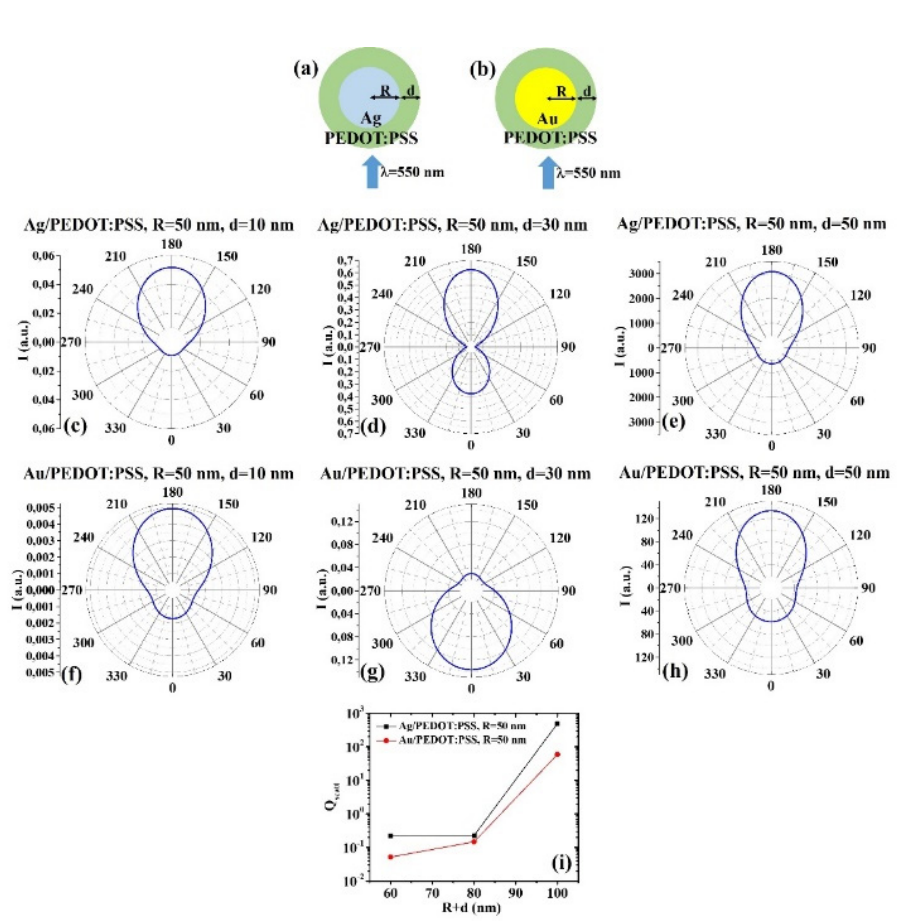
Figure 9. ( a , b ) Scheme of the structure of the simulated Ag/PEDOT:PSS ( a ) and Au/PEDOT:PSS ( b ) core–shell spherical particle with core radius R and shell width d and electromagnetic radiation of wavelength λ = 550 nm impinging on the particle from 0°. ( c – e ) Calculated polar diagrams for the intensity of the scattered light from the Ag/PEDOT:PSS core–shell spherical particle fixing the Ag core radius R to 50 nm and increasing the PEDOT:PSS shell width from 10 nm to 50 nm. ( f – h ) Calculated polar diagrams for the intensity of the scattered light from the Au/PEDOT:PSS core–shell spherical particle fixing the Au core radius R to 50 nm and increasing the PEDOT:PSS shell width from 10 nm to 50 nm. ( i ) Calculated scattering efficiency for the light (wavelength λ = 550 nm) scattering process of the Ag/PEDOT:PSS (black dots) and Au/PEDOT:PSS (red dots) core–shell spherical particles fixing the core radius to R = 50 nm and increasing the PEDOT:PSS shell width d from 10 nm to 50 nm. (c) R = 70 nm: Figure 10a, b reports the scheme of the structure of the simulated Ag/PEDOT:PSS (Figure 10a) and Au/PEDOT:PSS (Figure 10b) core–shell spherical particle with core radius R and shell width d and electromagnetic radiation of wavelength λ = 550